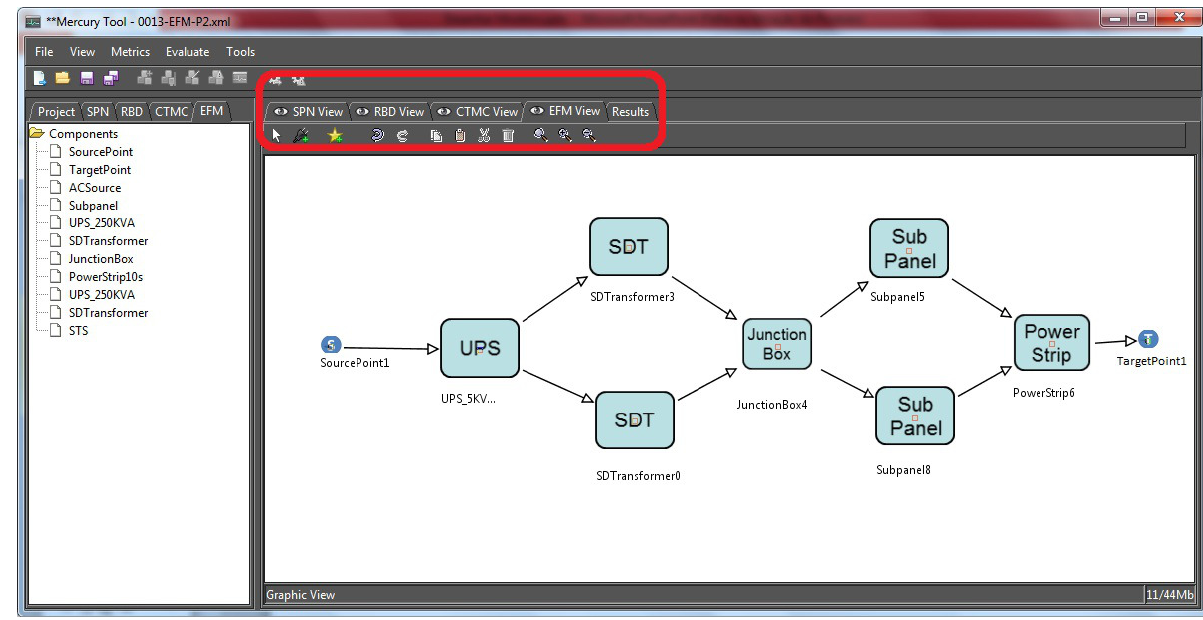
Figure 3. Mercury